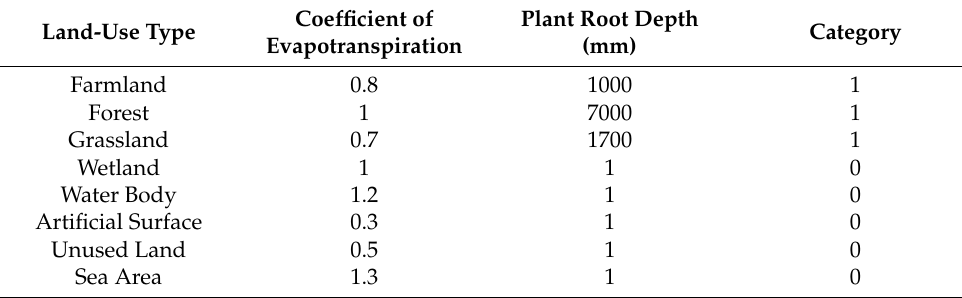
Table 2. Biophysical table using in water